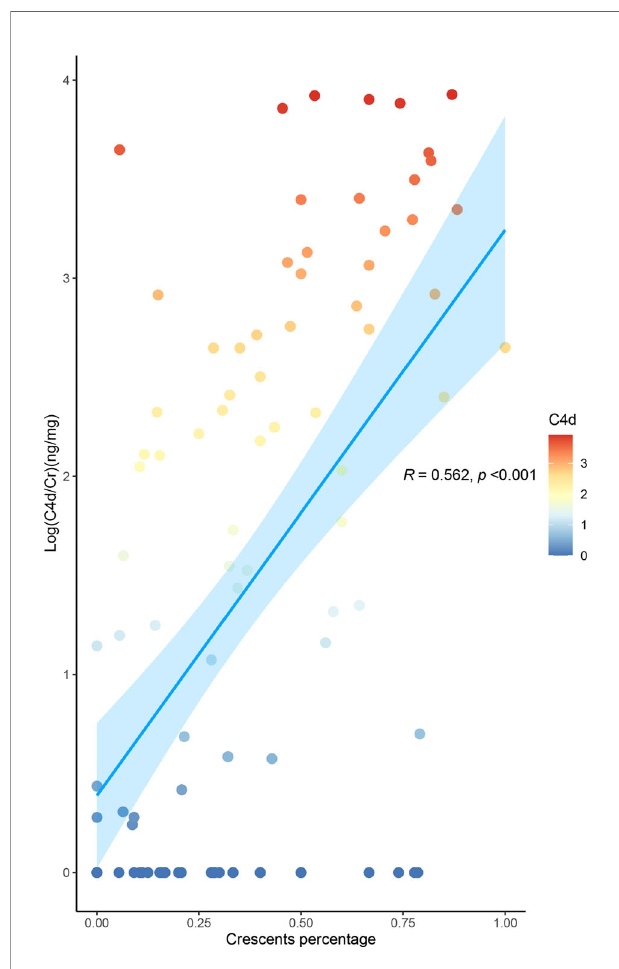
FIGURE 2 | Level of urinary C4d is associated with the proportion of crescents in IgA nephropathy. The urine values were corrected by urinary creatinine. All the data were log10-transformed.